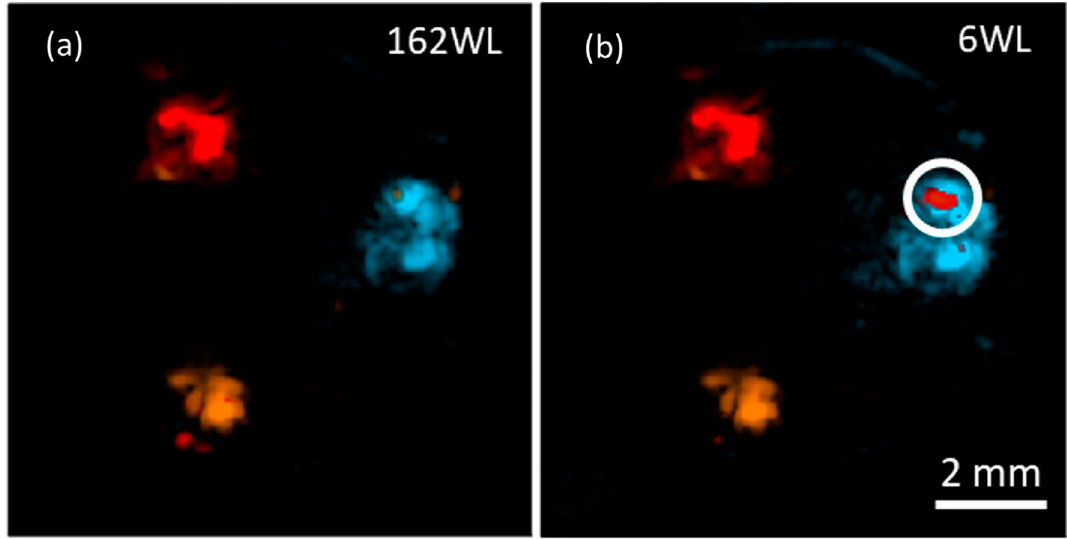
Figure 3. Wavelength selection analysis. ( a ) is the proportion map obtained using 162 wavelengths and ( b ) the result using an optimized set of 6 wavelengths.